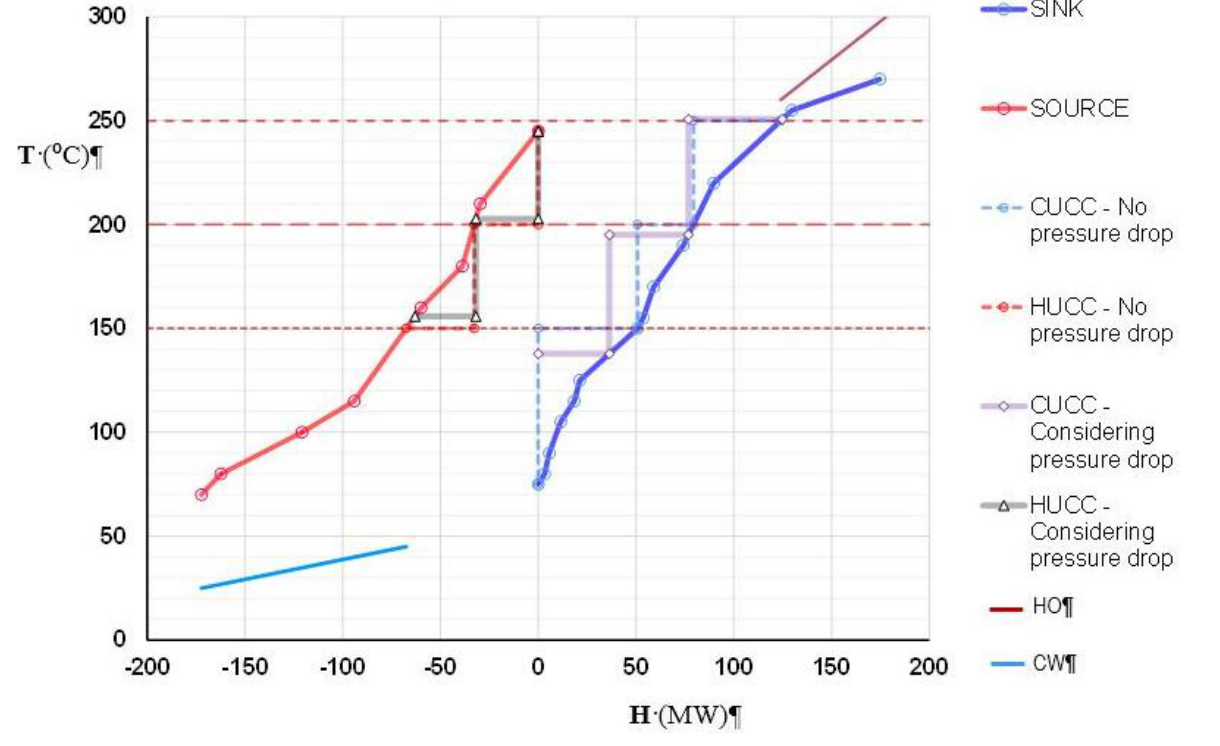
Figure 8. Simplified plot plan and elevation drawing for the